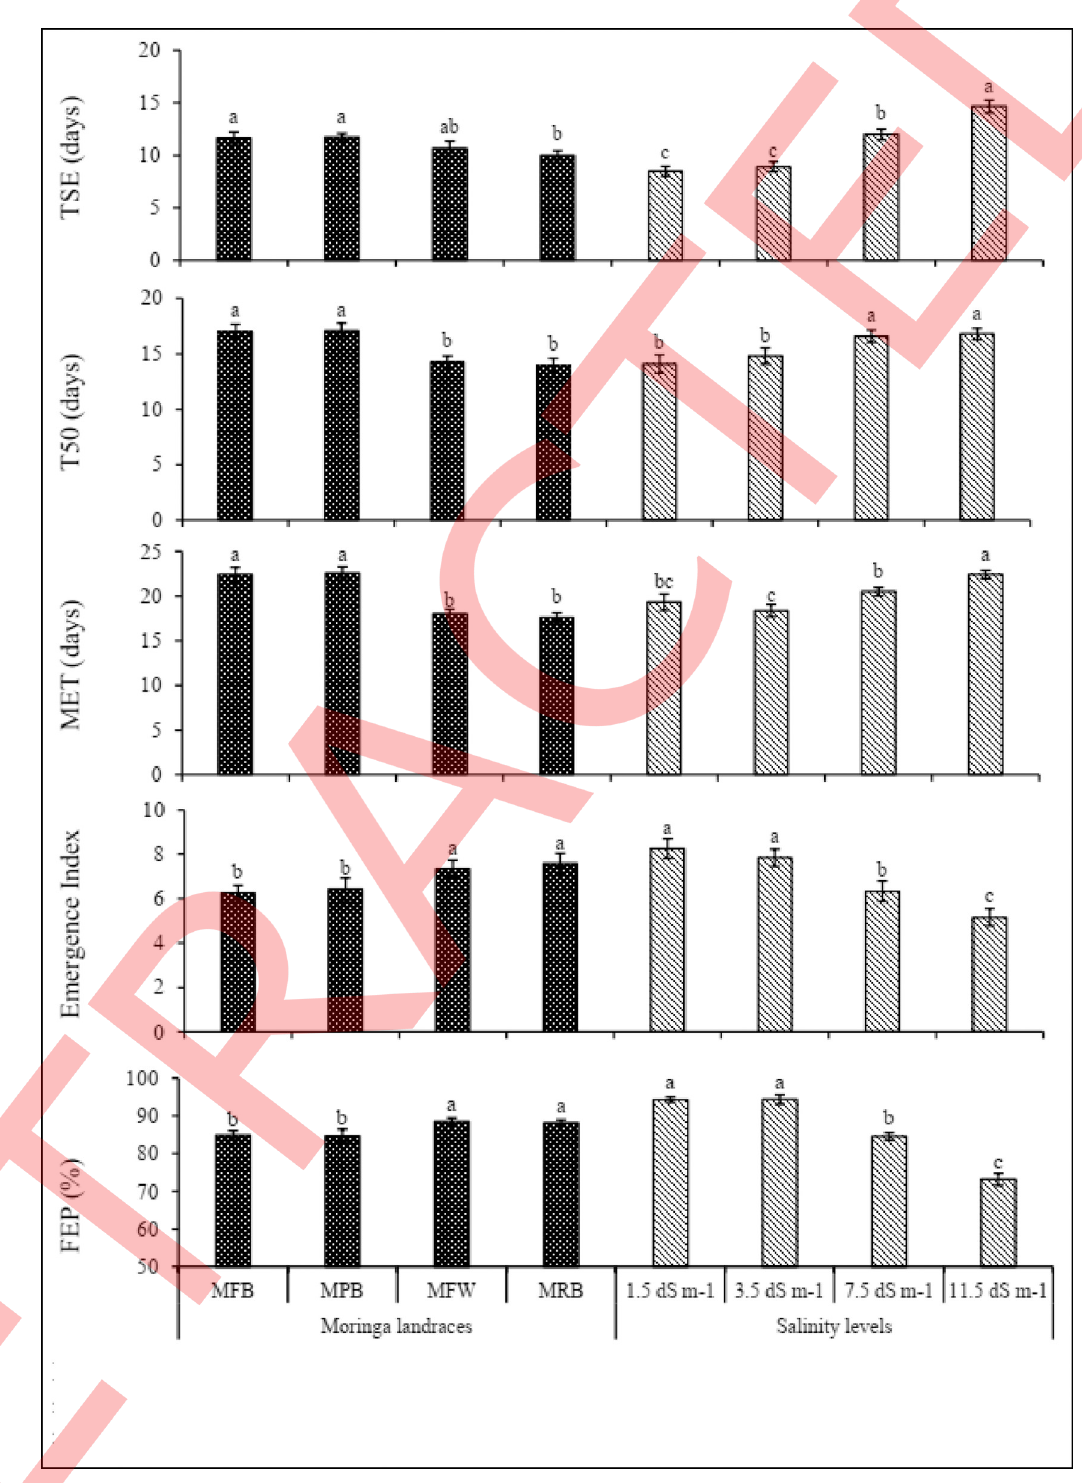
Fig 1. Impact of salinity on time to start emergence (TSE), time to 50% emergence time (T50), mean emergence time (MET), emergence index and final emergence percentage (FEP) of moringa landraces.